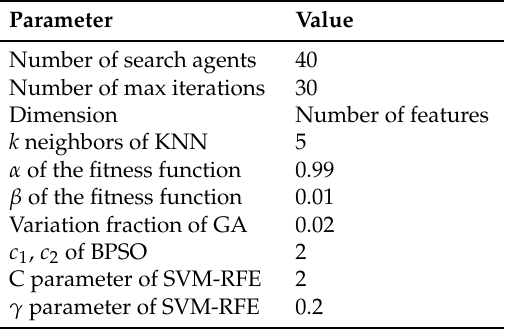
Table 5. Parameter